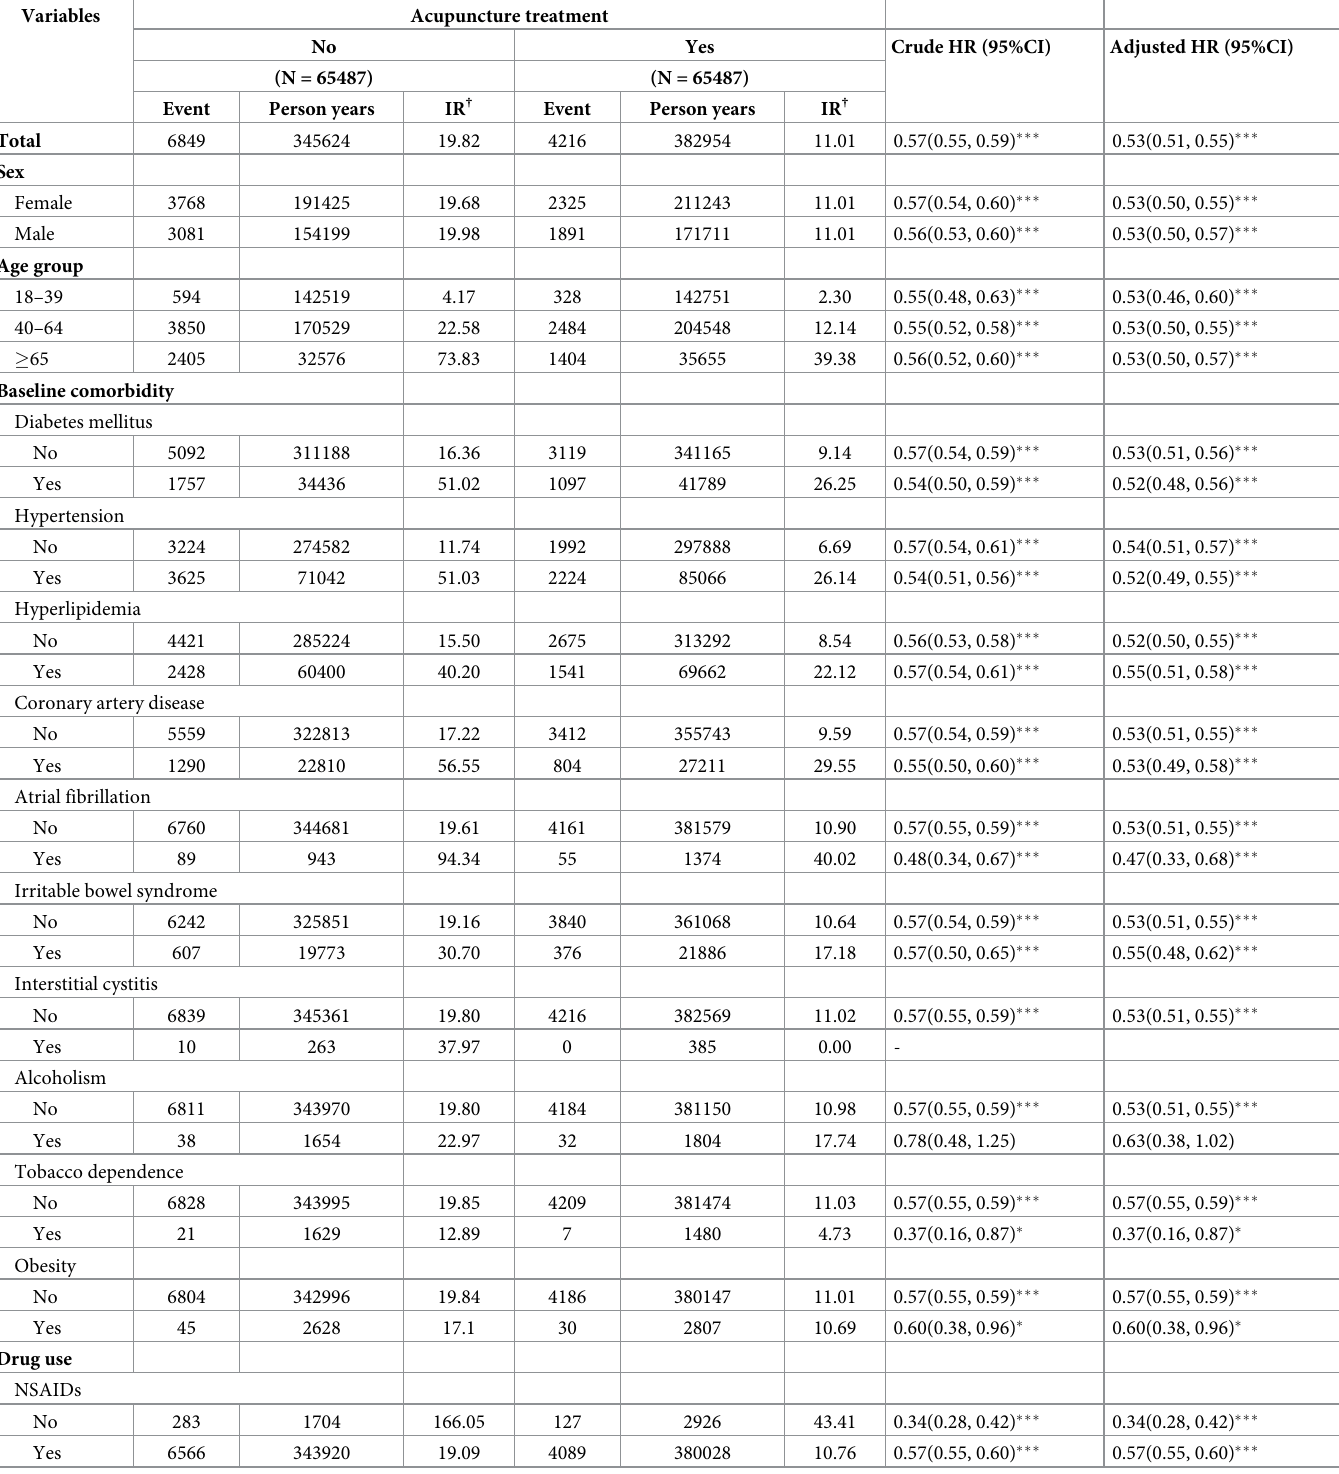
Table 3. Incidence rates, hazard ratio and confidence intervals of stroke for fibromyalgia patients who did and did not undergo acupuncture in the stratification of sex, age, comorbidities, and drugs use.